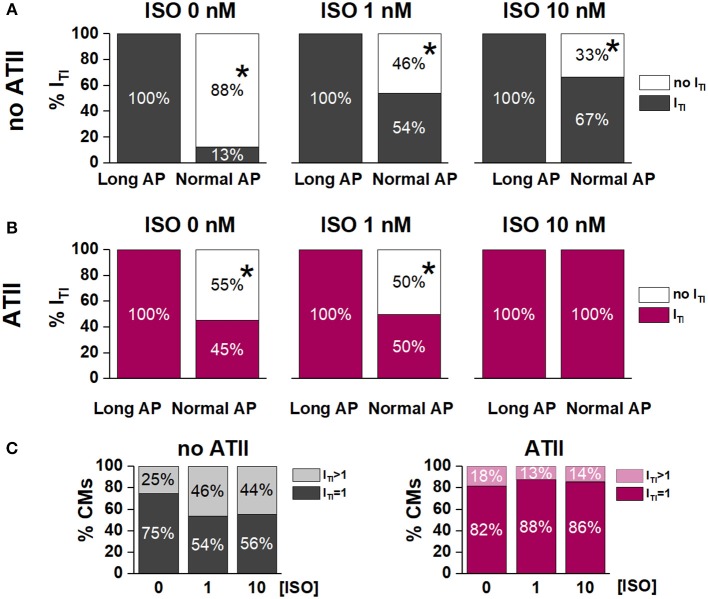
Effect of APD shortening on ITI incidence within the same cardiomyocyte in the absence (no ATII) (A) or presence of ATII (ATII) (B). (C) Percent of cardiomyocytes with 1 ITI event or >1 ITI events in the absence (no ATII) or presence (ATII) of ATII (Long AP; 0, 1,10 nM ISO). CMs: cardiomyocytes. N > 8 for all groups. *p < 0.05 vs. Long AP.